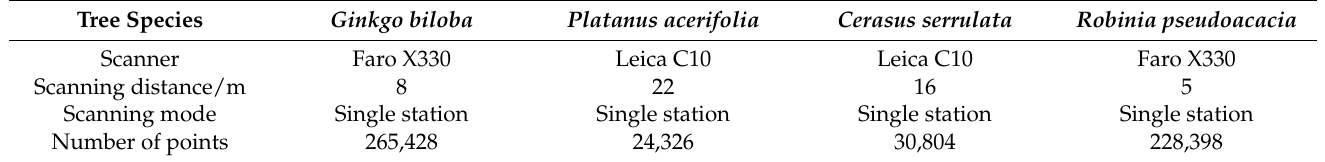
Table 1. The information of experiment individual